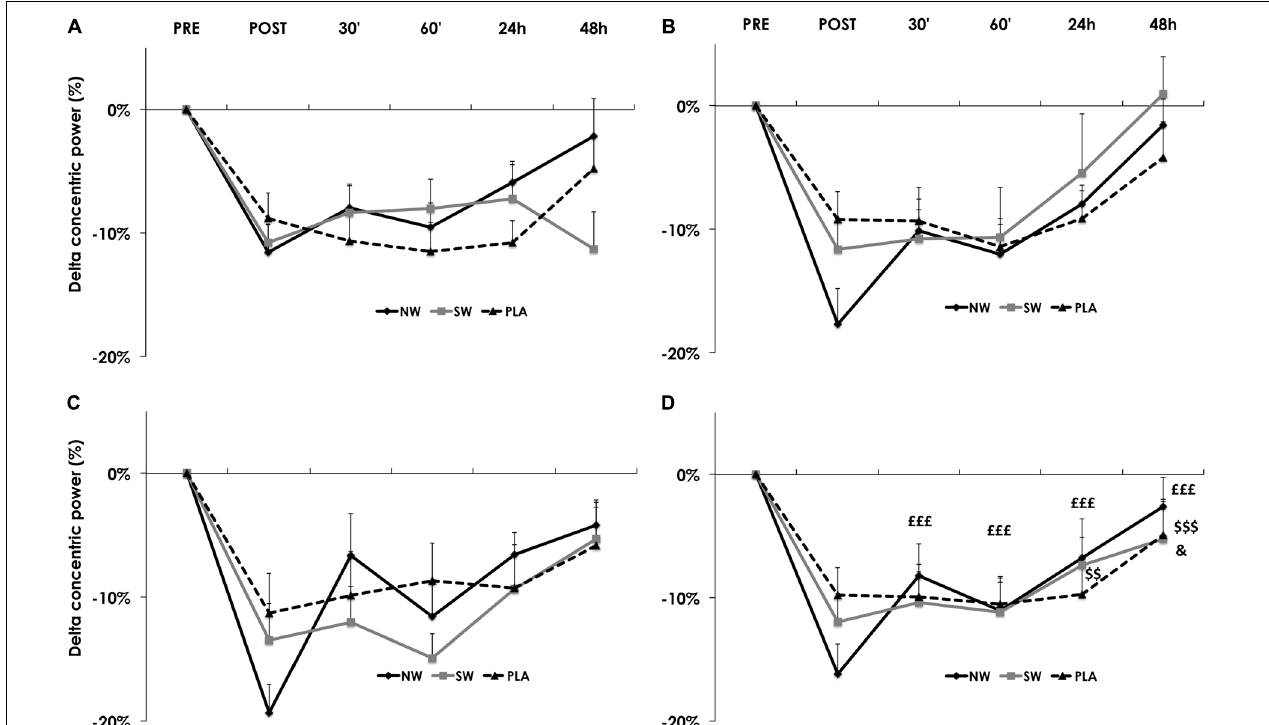
FIGURE 4 | Recovery kinetics of the concentric power, measured before (PRE), after (POST) and 30 (cid:48) , 60 (cid:48) , 24 h, and 48 h after the electrostimulation (ES) training session. Data from S1 (A) , S4 (B) , S24 (C) , and averaged over S1, S4, and S24 (D) . For the sake of clarity, values are expressed as the relative variation from PRE. Significantly different from POST in the NW group: ££££ p < 0.001. Significantly different from POST in the SW group: $$ p < 0.01, $$$ p < 0.001. Significantly different from POST in the PLA group: & p < 0.05.